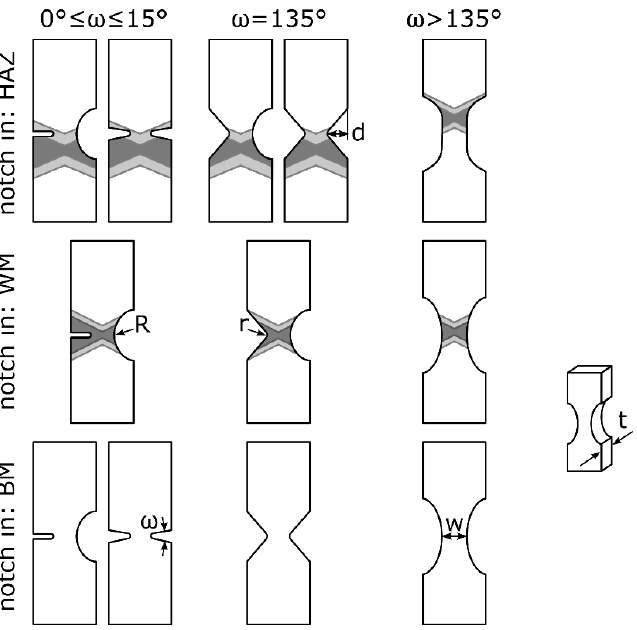
Figure 1. Overview of the specimens used for the evaluation (schematic, not to scale).